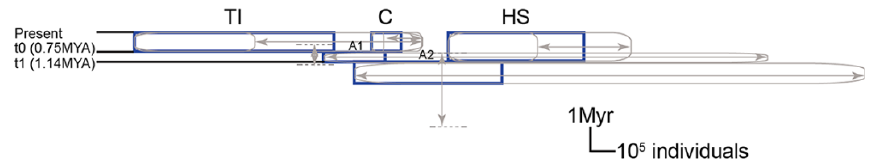
Figure 5. The reconstructed lineage divergence process inferred from a multi-population IMa2 anal- ysis of C. ramondioides . TI denotes sampled populations distributed in Taiwan and Iriomote, C denotes sampled populations distributed in Southeast China, and HS denotes sampled populations distributed in Honshu and Shikoku. In the cartoon plot, effective population size of each clade and lineage divergence time among groups are indicated by a box and horizontal lines, respectively. Blue boxes and blue horizontal lines are scaled to denote the mean measured parameters. Gray boxes and lines, including double arrows and dashed lines, are scaled to present the 95% confidence intervals of the corresponding parameters. A1 denotes the ancestor population of C and TI. A2 denotes the ancestor population of C, TI and HS.